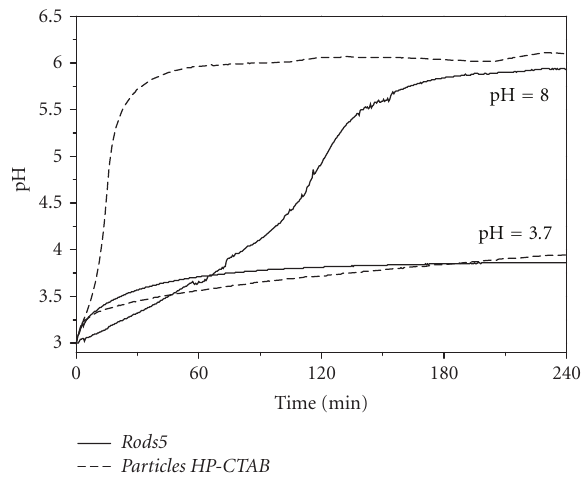
Figure 6: Influence of the modification pH on the chemical dura- bility of PEG- b -PAAc modified Gd 2 O 3 :Er 3+ ,Yb 3+ under acidic